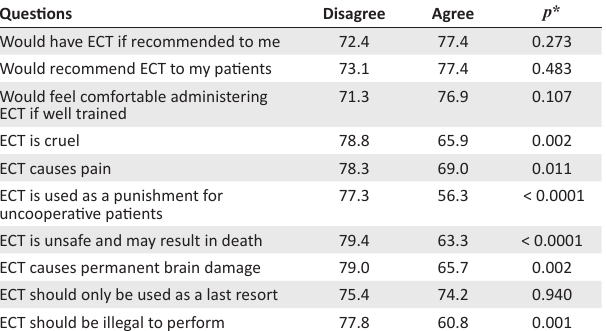
TABLE 5: Students’ electroconvulsive therapy knowledge scores across electroconvulsive therapy attitudinal questions. † Questions